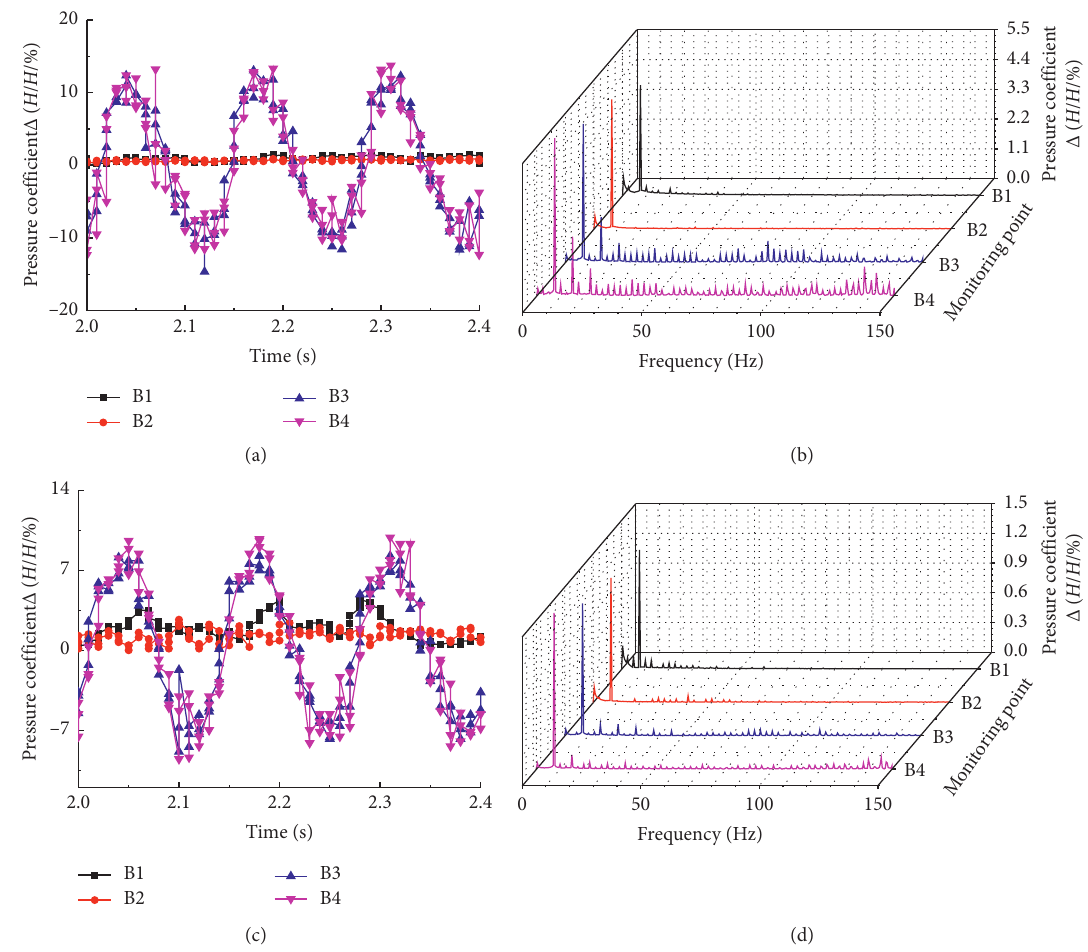
Figure 16: Optimization of pressure pulsation at the inlet and outlet monitoring points of the runner: (a) time-domain graph before optimization; (b) frequency domain graph before optimization; (c) time-domain graph after optimization; (d) optimized frequency domain